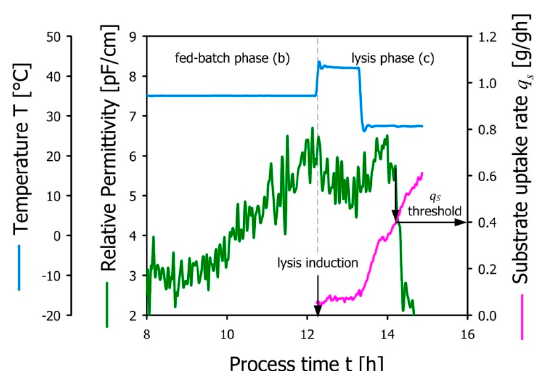
Figure 2. Determination of E-lysis onset based on permittivity measurements (green line) by increasing the specific substrate uptake rate q S (pink line). The threshold value of E-lysis onset was found for q S = 0.4 g/gh.